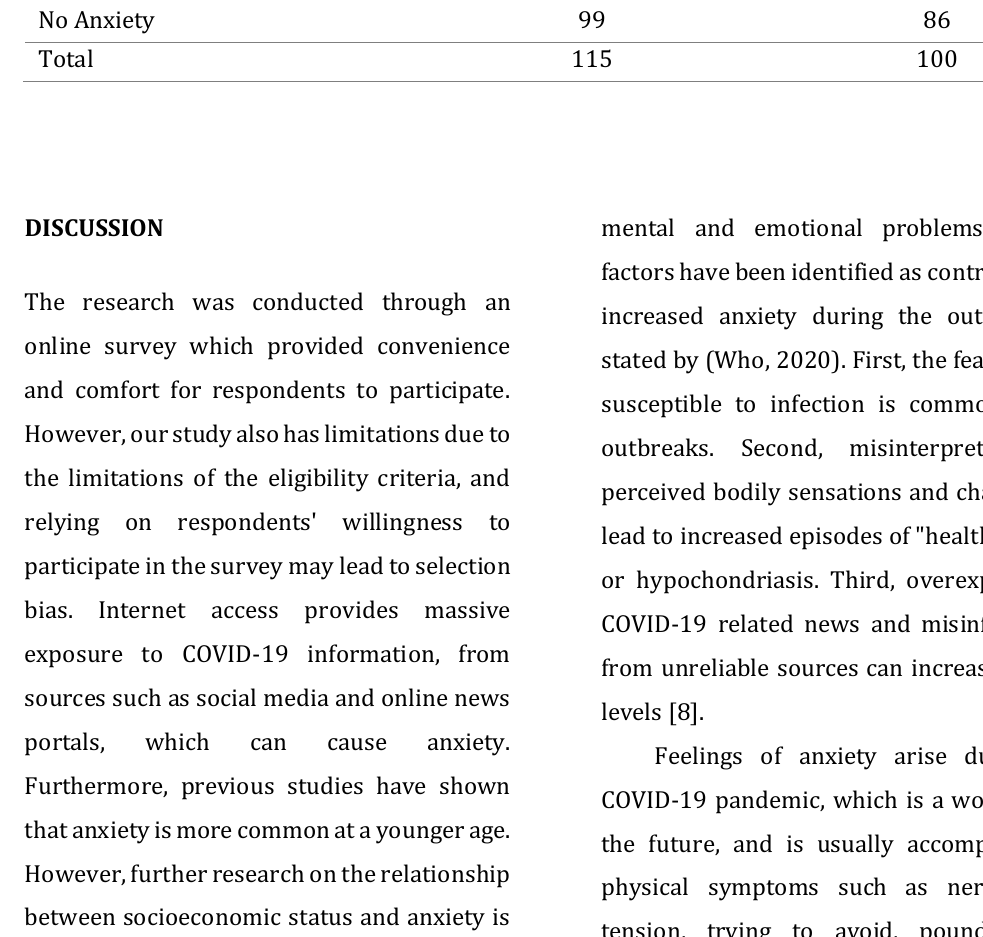
Table 5 Distribution of public anxiety due to the COVID-19 pandemic (n = 115) Anxiety Frequency Percentage (%)